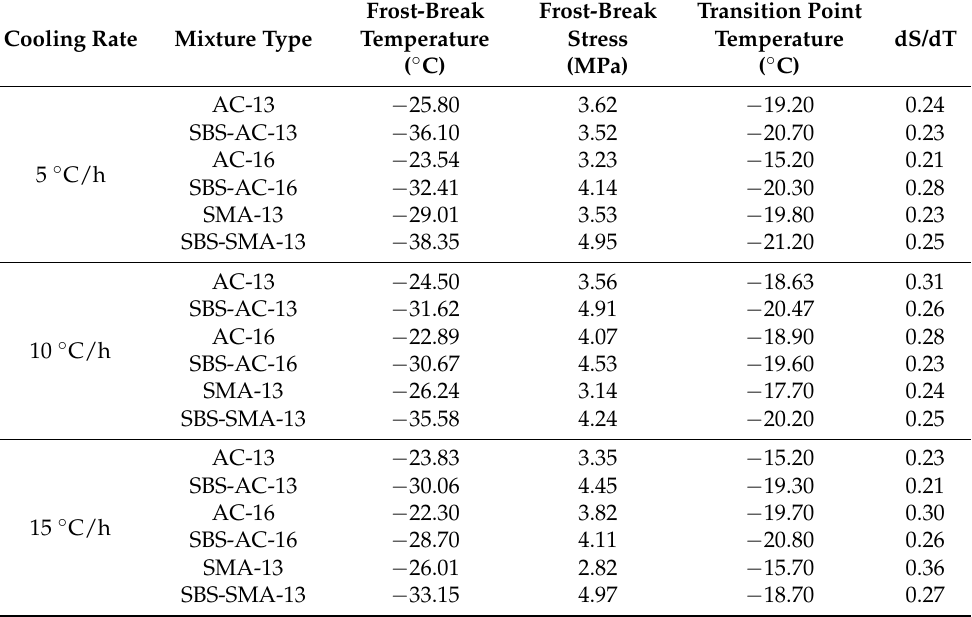
Table 5. TSRST results of asphalt mixture